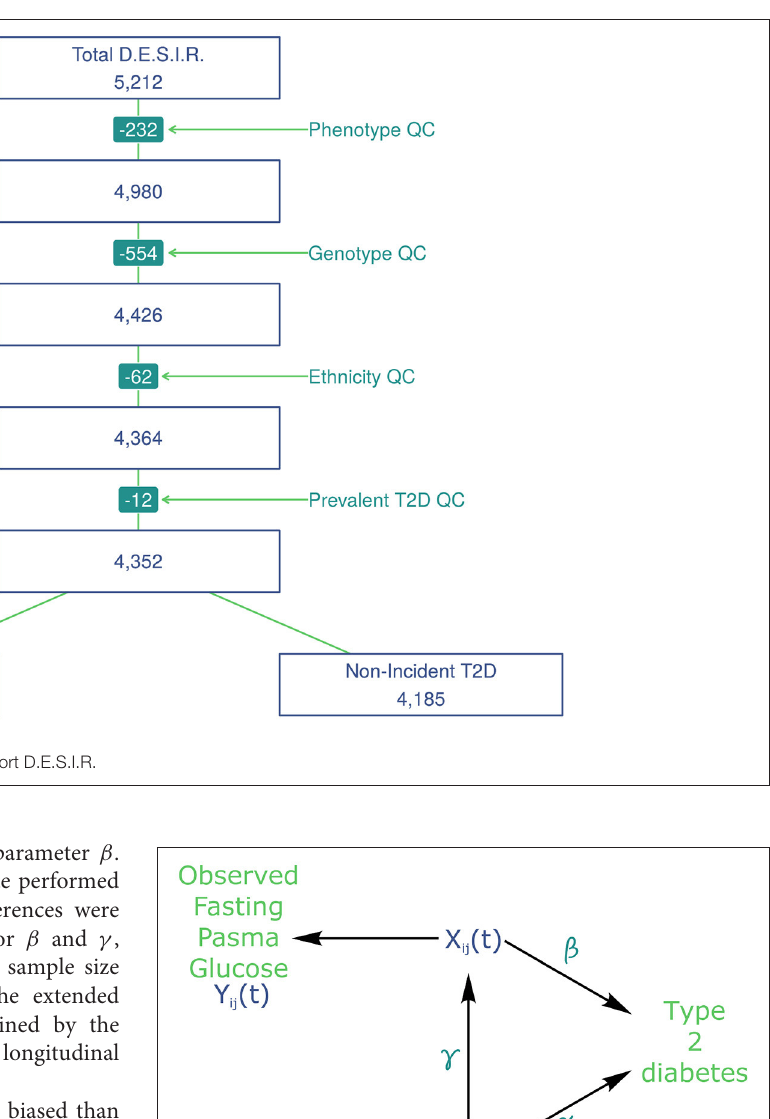
FIGURE 2 | Causal diagram for joint modelling applied to fasting plasma glucose (FPG) and type 2 diabetes (T2D) (adapted from Ibrahim et al., 2010). SNP: Single Nucleotide Polymorphism. X ij is the true (unobserved) FPG trajectory. β measures the association between FPG trajectory and T2D incidence. exp ( α ) measures the hazard ratio for T2D. γ measures the association between a SNP i and FPG